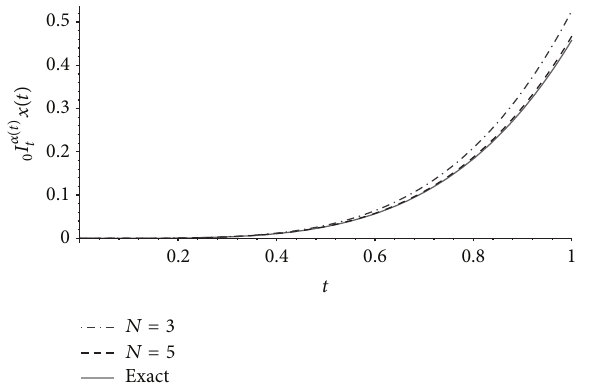
Figure 2: Exact (46) and numerical approximations of the left Riemann-Liouville derivative 0 𝐷 𝛼(𝑡) 𝑡 𝑥(𝑡) with 𝑥(𝑡) = 𝑡 4 and 𝛼(𝑡) = (𝑡 + 1)/4 obtained from Theorem 4 with 𝑛 = 2 and 𝑁 ∈ {3, 5} . The error (48) is 𝐸 ≈ 0.03294 for 𝑁 = 3 and 𝐸 ≈ 0.003976 for 𝑁 = 5 .